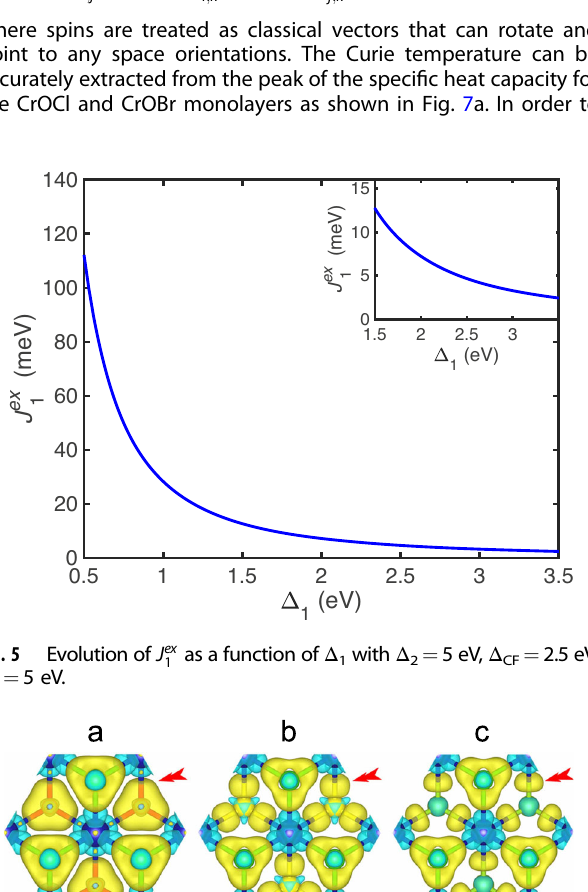
Fig. 6 Differential charge density of CrXCl monolayers. Differential charge density of ( a ) CrOCl, ( b ) CrSCl and ( c ) CrSeCl monolayers, where yellow and cyan regions denote charge accumulation and depletion with the isosurface being set to 0.06 e/ Å 3 . The red arrow indicates the electron in the center of the Cr – X bond.